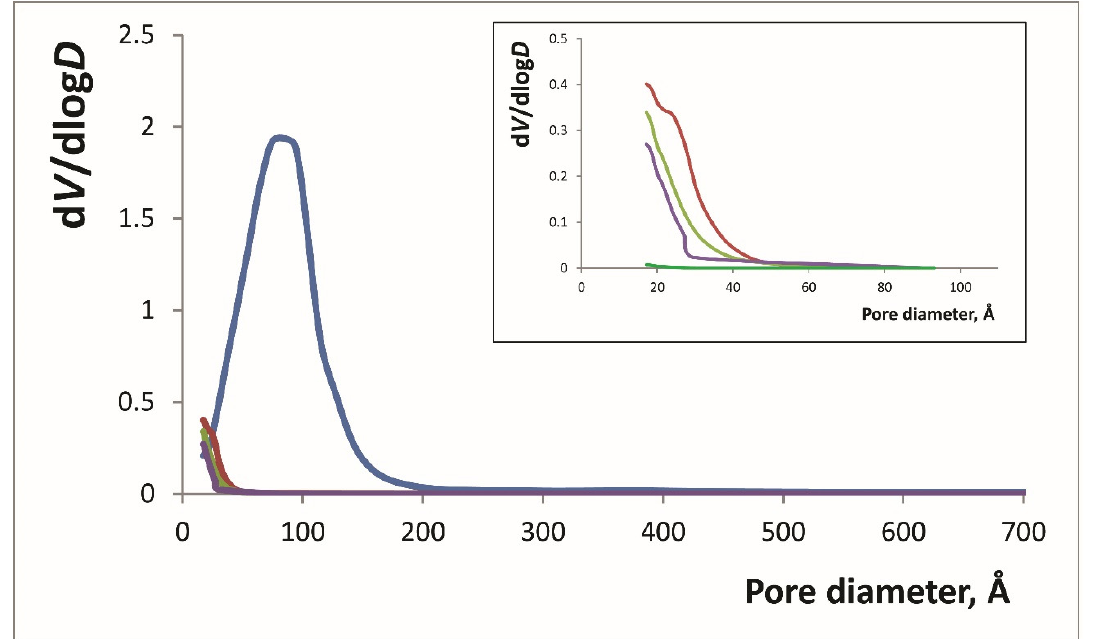
Figure 1. Pore size distribution according to the BJH method calculated from the desorption branches for different xerogels (see Table 1): SiFe (blue), SiTi5Fe (red), SiTi12.5Fe (yellow), SiTi12.5Fe/Phen (purple), SiTi12.5Fe100 (green).